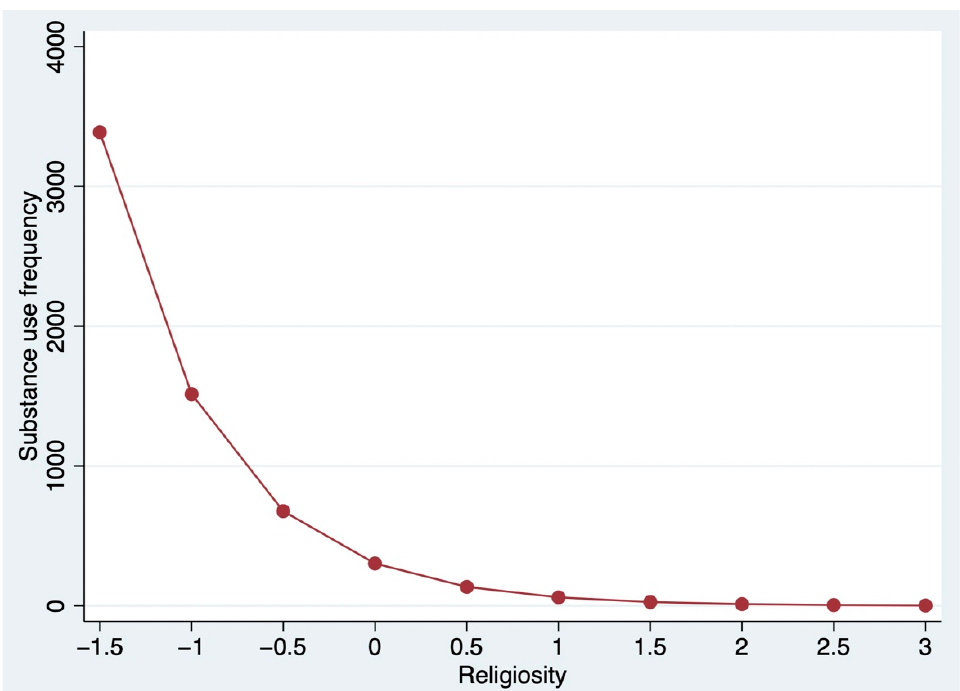
Figure 1. The moderated relationship between religiosity and adolescent substance use frequency by Christianity. Note: The measure of religiosity in the regression analysis is the mean of the standardized scores of the responses to the three questions about religious commitment.